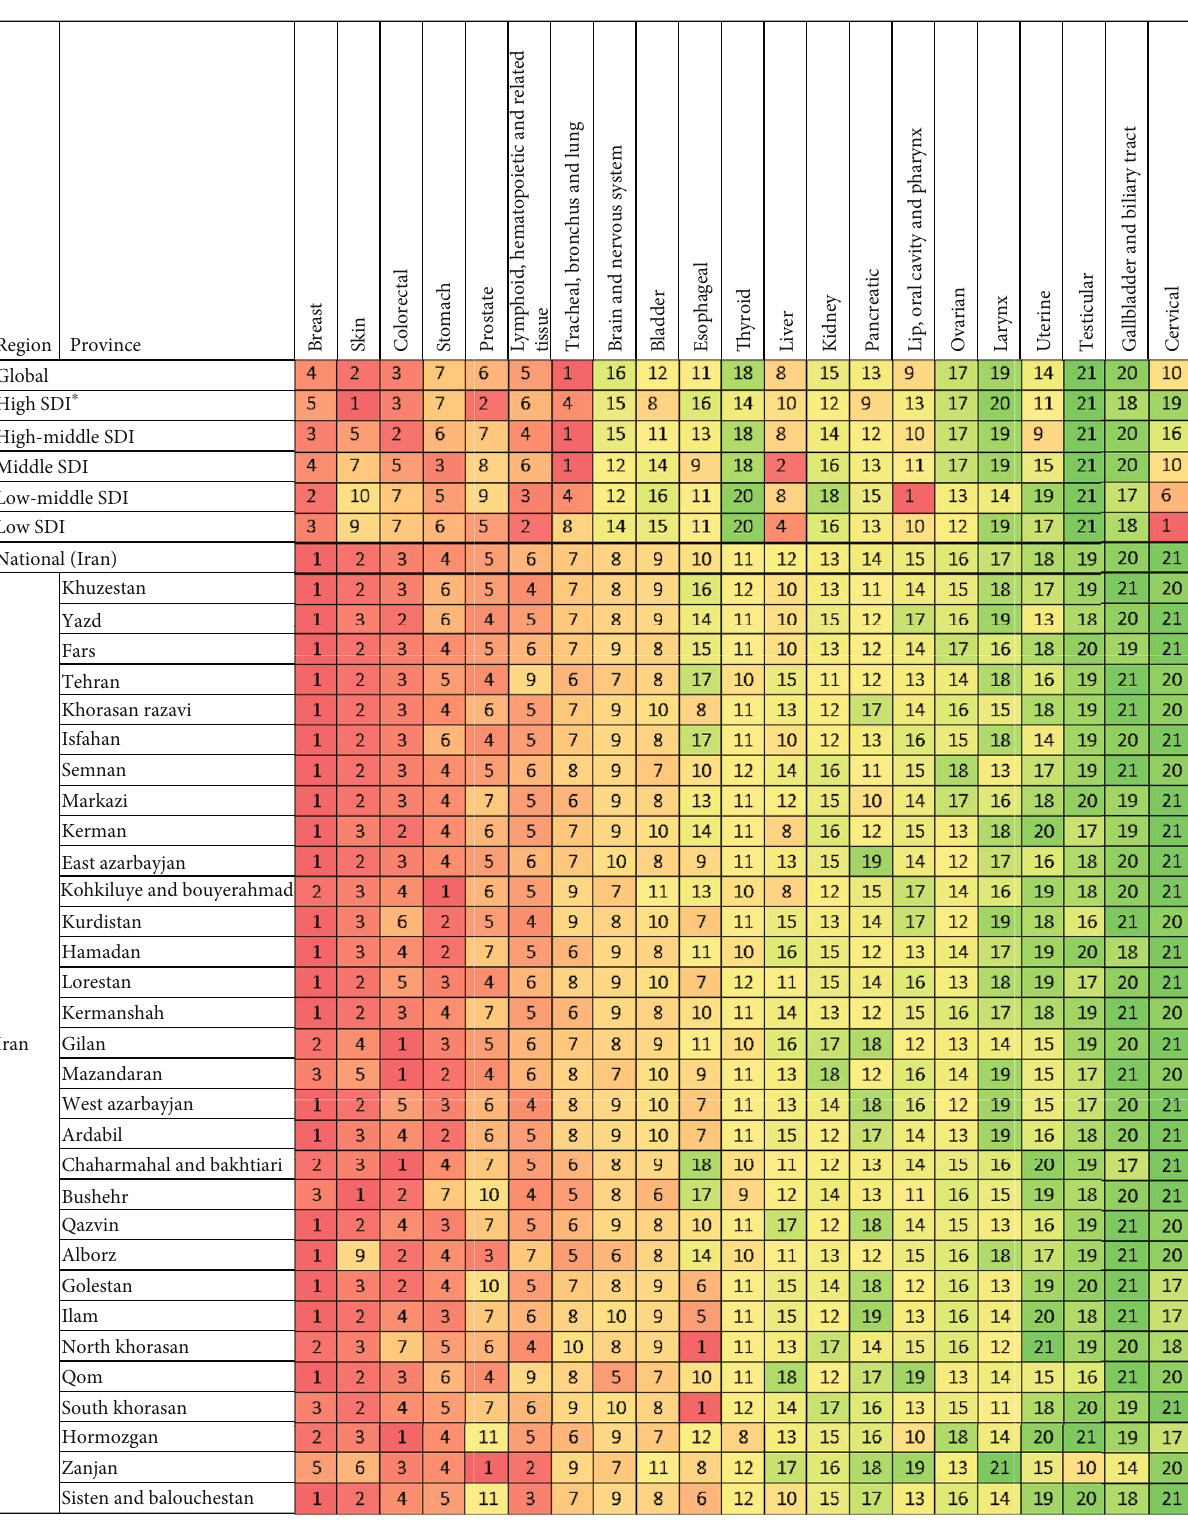
Figure 3: Cancers ranked by number of incident cases in both sexes, globally, by development status, nationally, and provincially in 2016. Colors correspond to the ranking (dark red is the cancer group with the most incidence, and dark green is the cancer group with the least incidence for the location indicated). The numbers inside each box indicate the ranking. The cancers were sorted by their ranking in national incidence. “ Other cancers ” group is not included in the ranking. ∗ SDI: social development